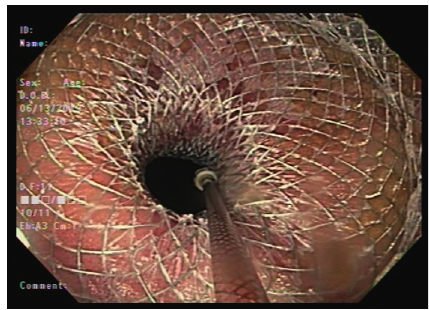
Figure 3: Retroflexion perspective demonstrating the proximal aspect of the deployed LAMS.